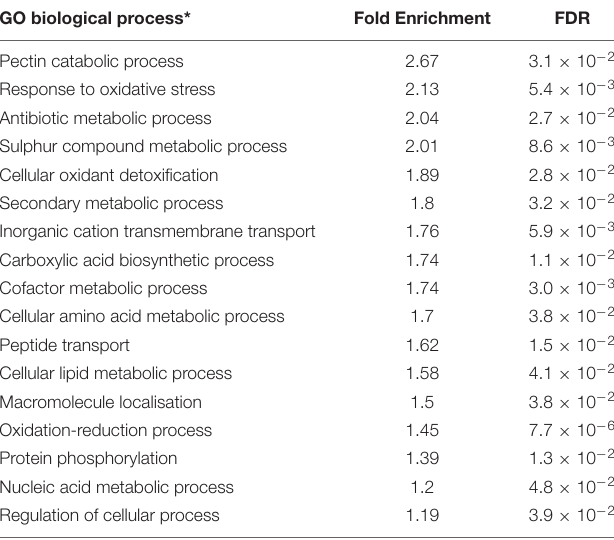
TABLE 1 | GO terms from the biological process ontology significantly over-represented amongst genes with CHH DMRs overlapping either the promoter or transcribed region.